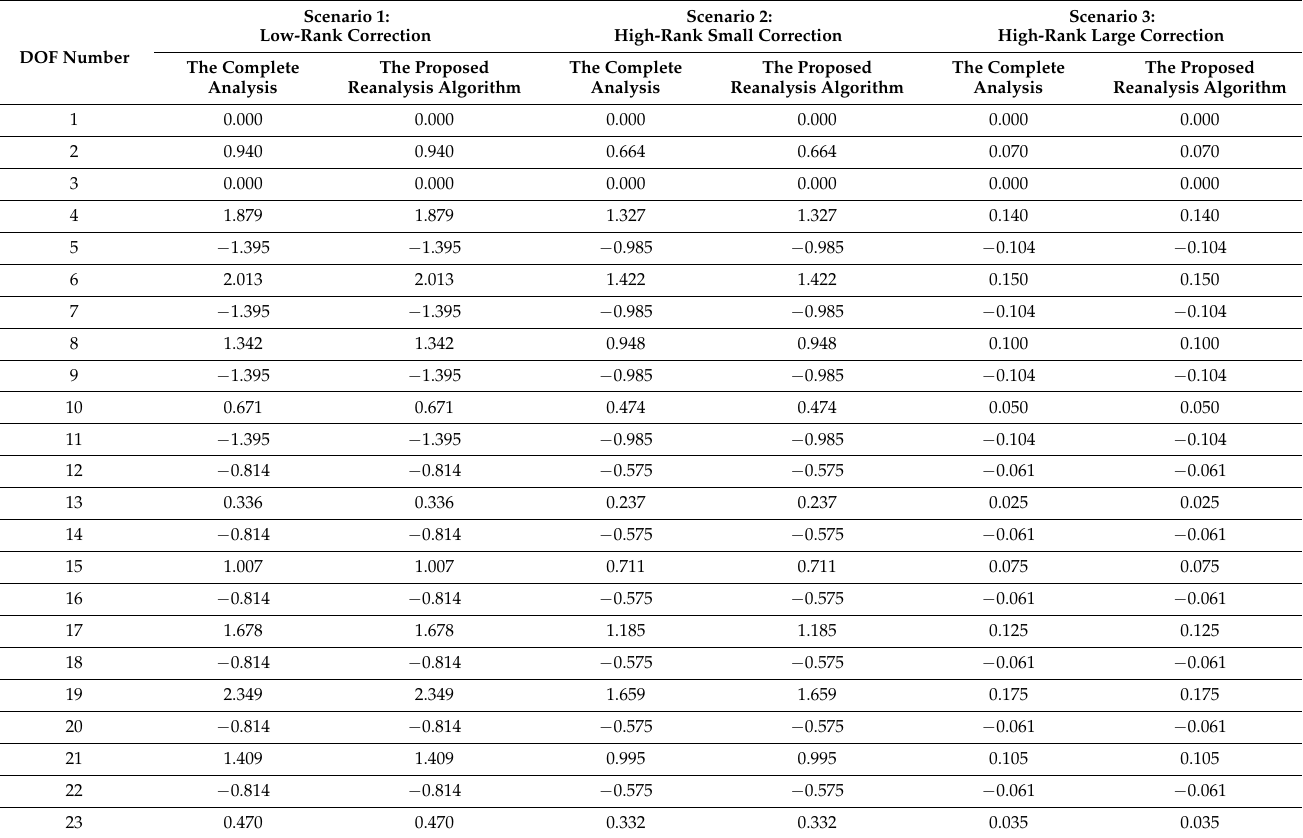
Table 2. The first-order sensitivities of displacements for modified structures ( × 10 − 3 ).